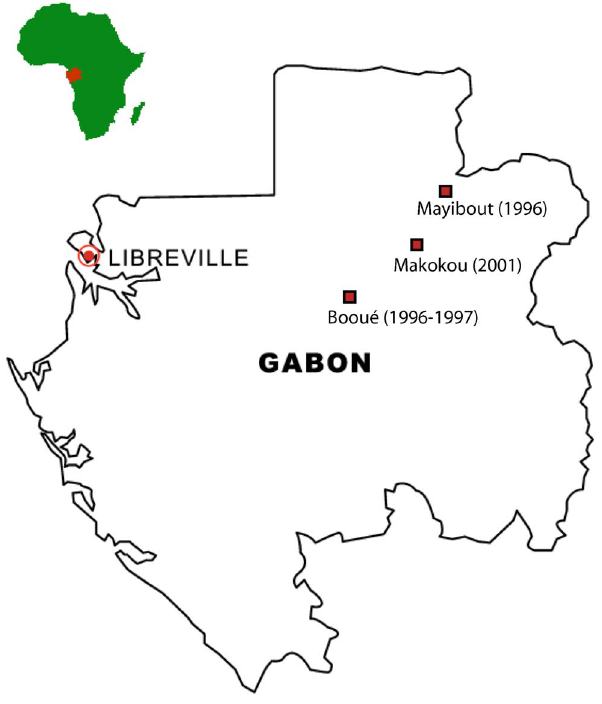
Figure 1. Map of Gabonese villages where the 1996 and 2001 outbreaks